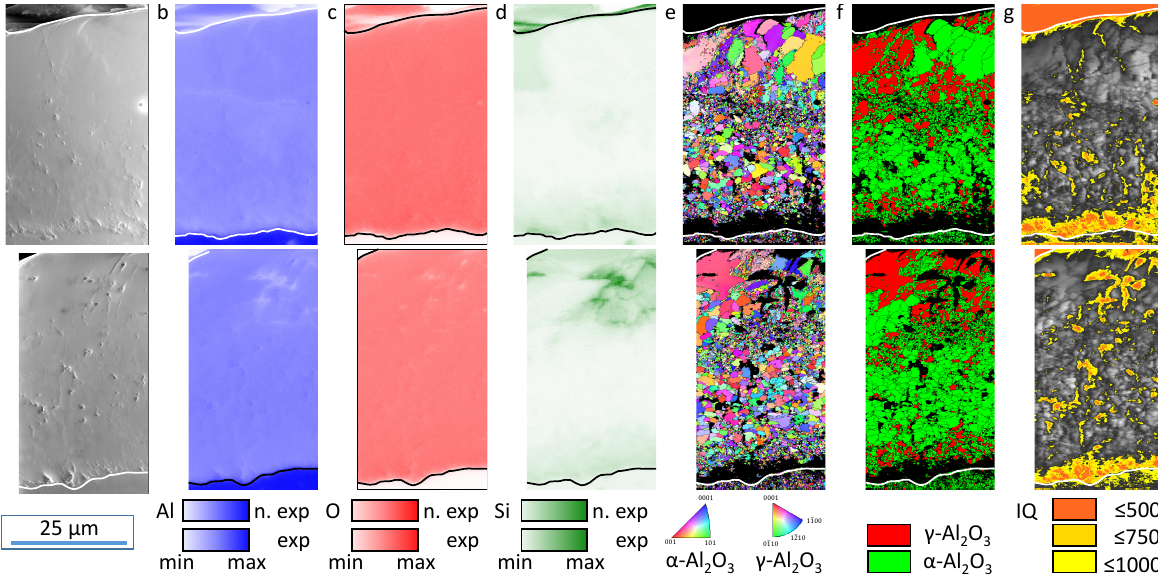
Figure 9. SEM ( a ) image as well as EDX ( b – d ) and EBSD ( e – g ) maps for the cross-section of a sample exposed to electrolyte II at unaffected (top) and affected (bottom) surface regions (Pos. 1 and 2 in Figure